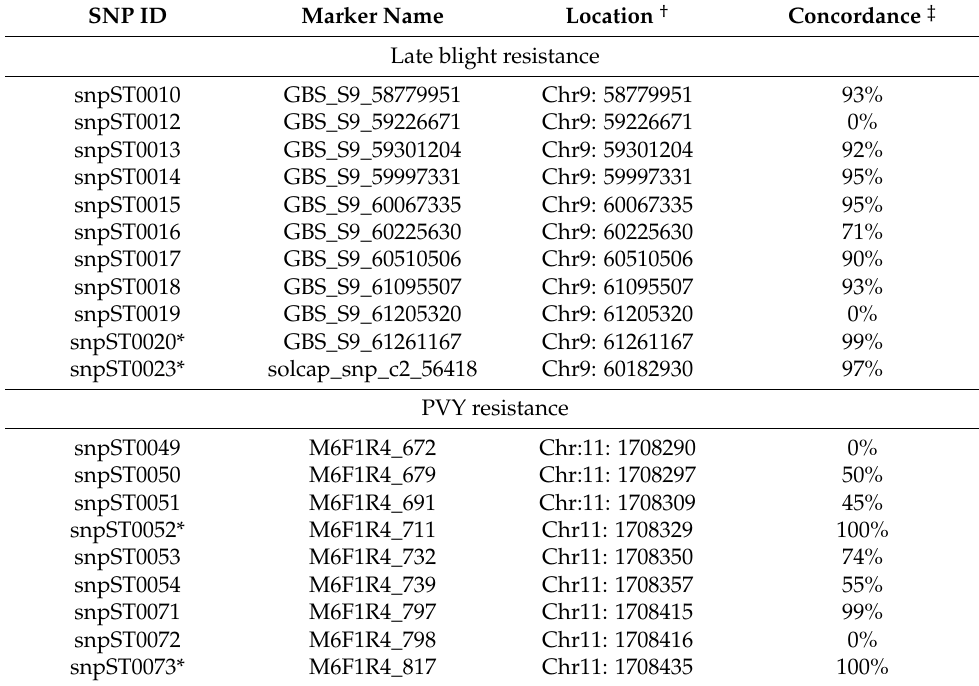
Table 3. Quality evaluation of the single nucleotide polymorphism (SNP) markers converted into the kompetitive allele specific PCR (KASP) system. Markers selected for breeding are indicated with an asterisk. SNP ID is the identification in the Intertek potato KASP marker